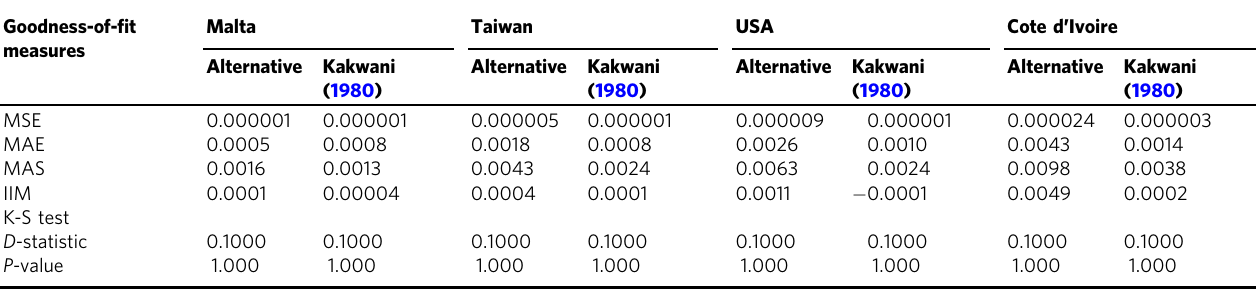
Table 9 The comparison of the values of goodness-of- fi t statistical measures between the alternative functional form that is based on the weighted average of the exponential function and the functional form implied by Pareto distribution and the Kakwani (1980) ’ s functional form.